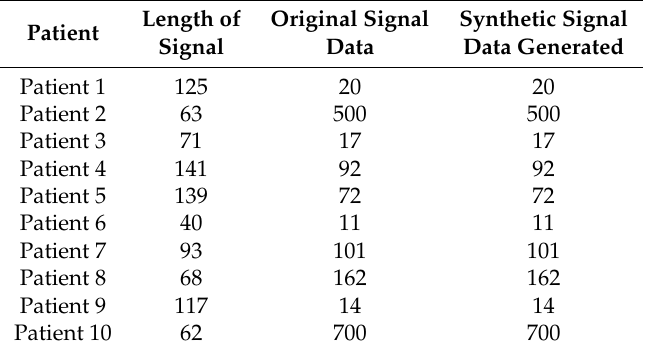
Table 5. Details of Synthetic Photoplethysmography (PPG) Signals Generated.